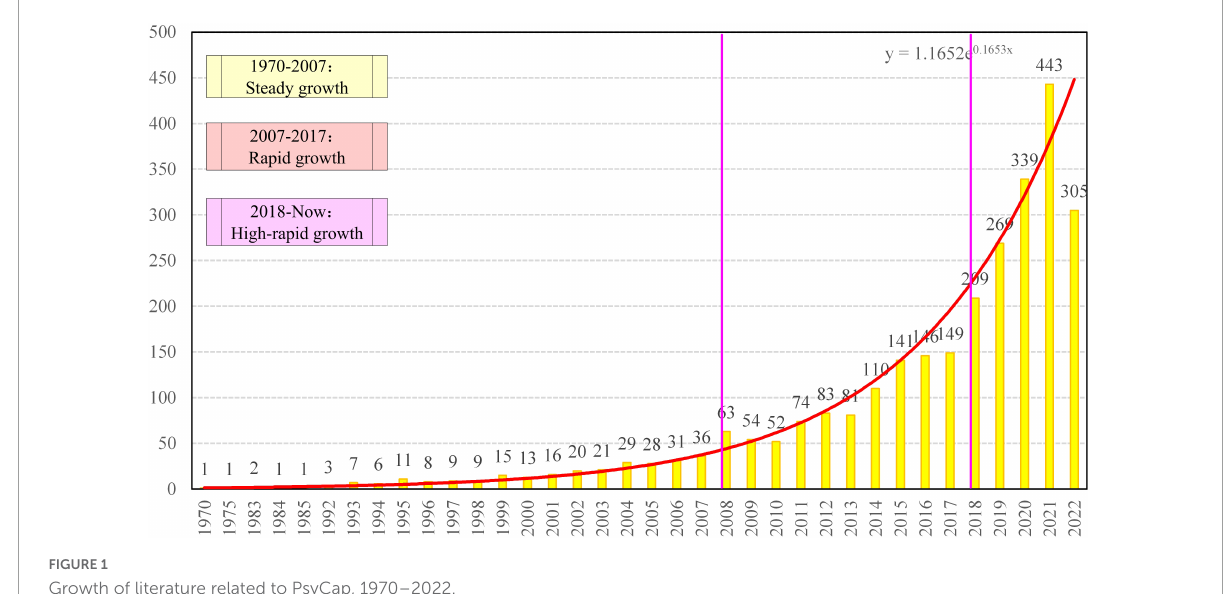
FIGURE1 Growth of literature related to PsyCap, 1970–2022.